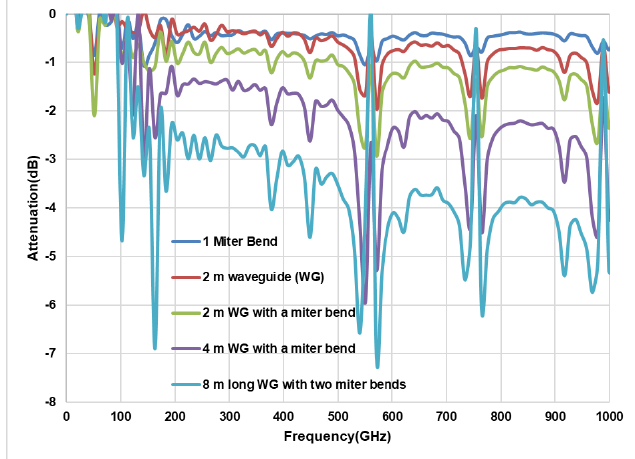
Fig. 4: Measured attenuation for various length of the smooth walled waveguide